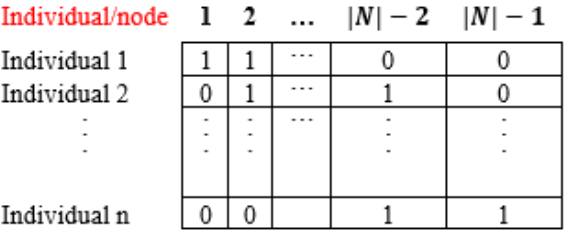
Figure 3. Codification proposed for the matrix population(Adapted from